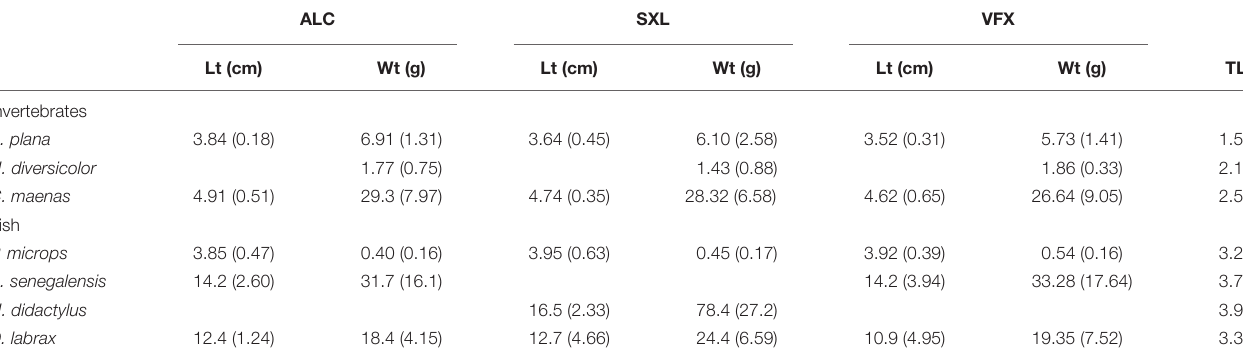
TABLE 2 | Mean (and standard deviation) of length (Lt in cm), and weight (Wt in g) of invertebrates and fish sampled per estuarine site (ALC, SXL, and